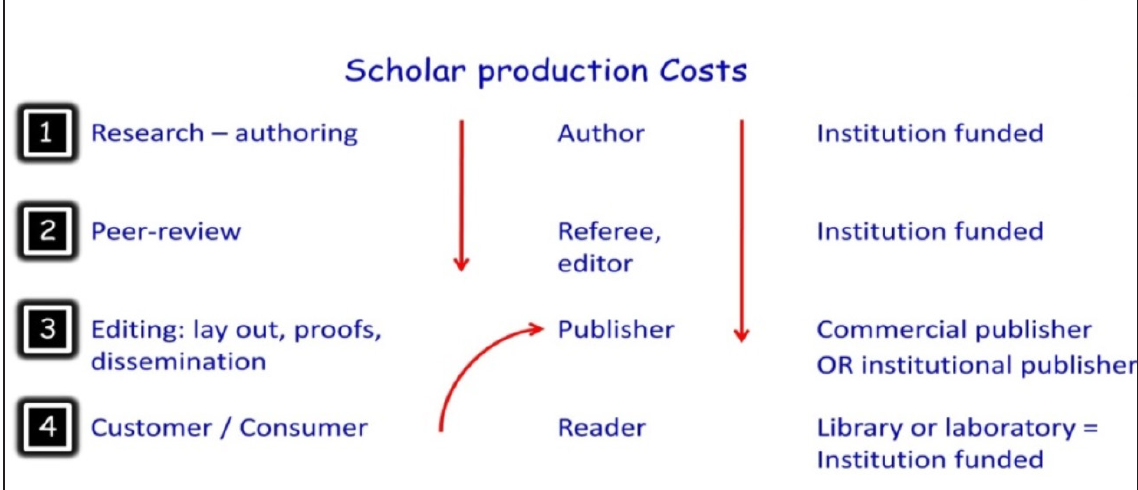
Fig. 14. Scholar production costs. Four steps are needed to produce scholar papers, of which three are publicly-funded. In the first scenario, the library pays back the final product by subscription to the publisher while in the second, the publishing costs are supported by the publisher (commercial or institutional) and then the access is free for